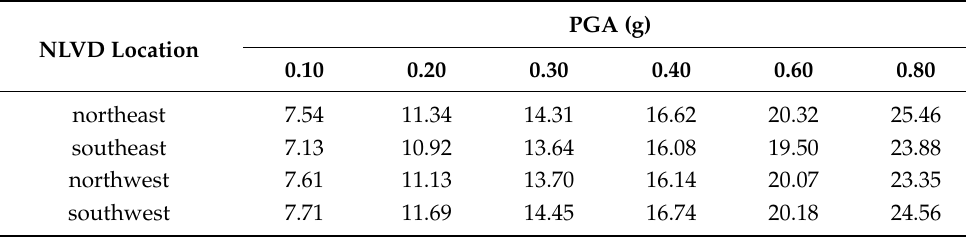
Table 9. Maximum axial force of the NLVDs (unit: kN)